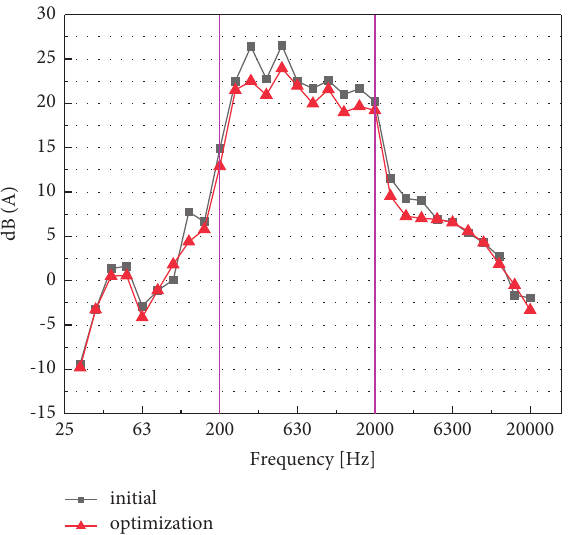
Figure 7: Frequency domain diagram of the noise of capillary outlet before and after